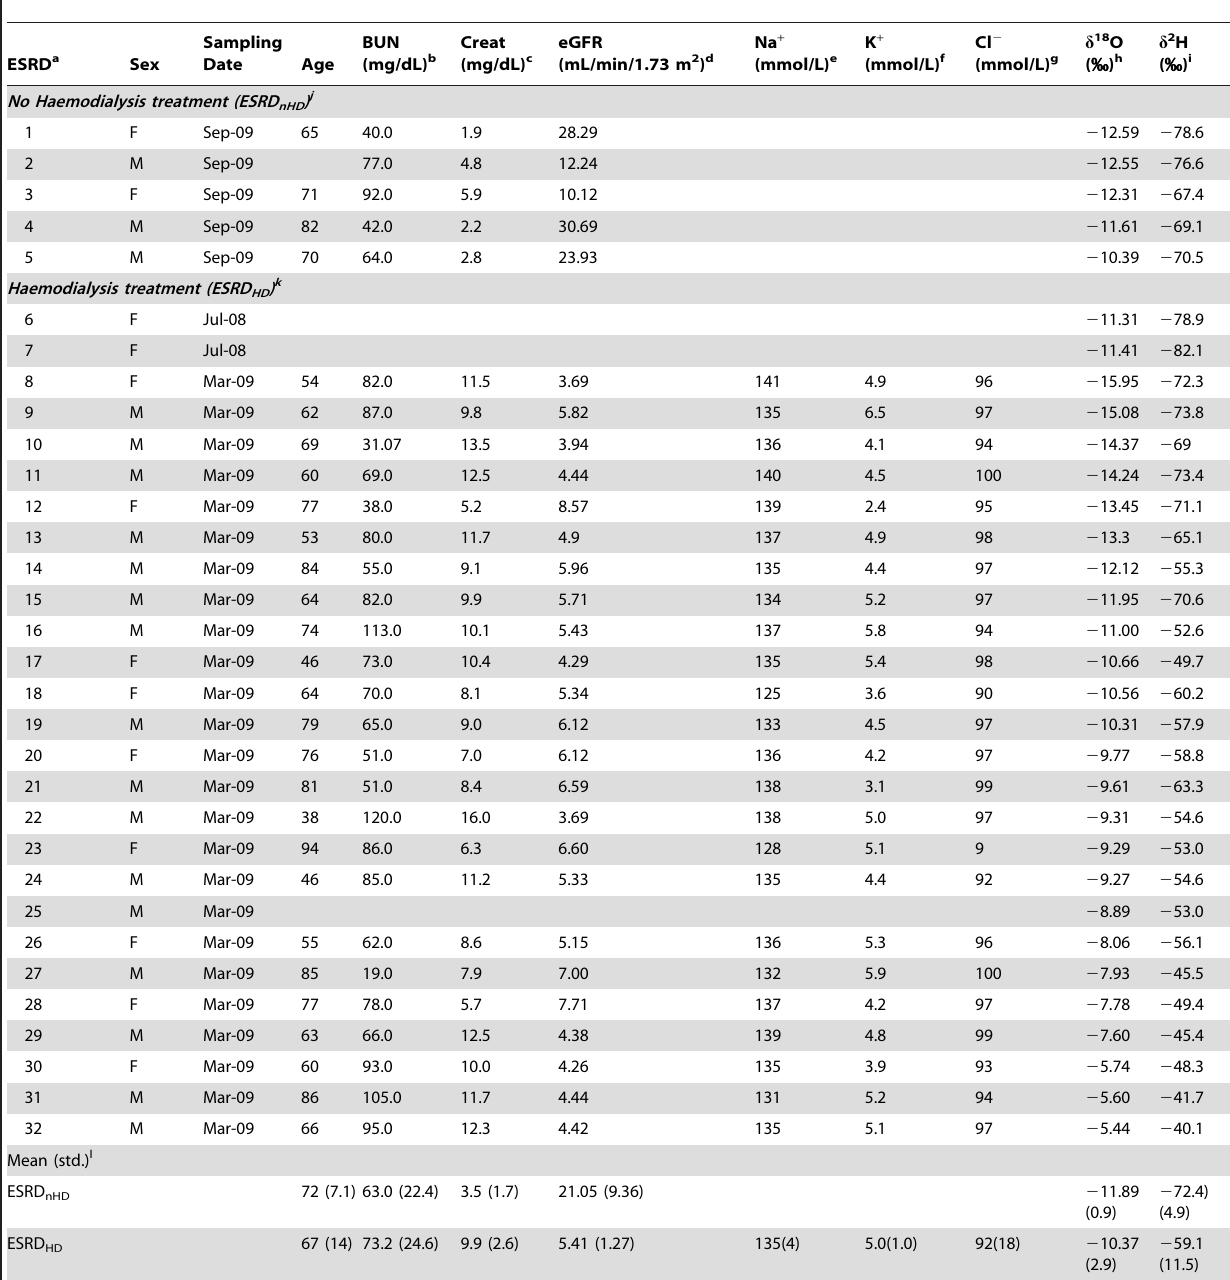
Table 2. Isotopic values of end stage renal disease (ESRD) patient’s blood plasma.